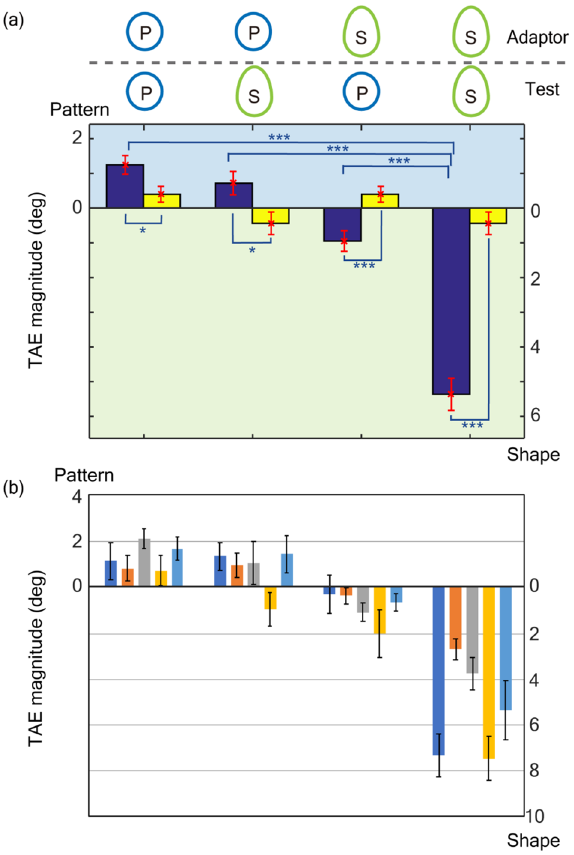
Figure 2. Measured TAE magnitudes, including transfer conditions (Exp. 1). ( a ) Mean magnitudes across the participants. Icons on the top indicate the combination of adaptor and test types (P and S denote symmetry in pattern and shape, respectively). Blue and yellow bars show the measured TAEs for the four conditions (from the left, TAE P,P , TAE P,S , TAE S,P , and TAE S,S ) and those for the corresponding blank conditions (TAE B ), respectively. The TAE with the adaptation to SP is plotted toward the positive direction in the ordinate (the scale on the left), whereas the TAE to SS is plotted toward the negative direction (the scale on the right) to clarify the transfer between SP and SS. ( b ) The measured magnitude of each participant. Colors indicate individuals. Error bars show the standard error (SEM), and asterisks denote statistical significance (*p < 0.05; **p < 0.01; ***p <